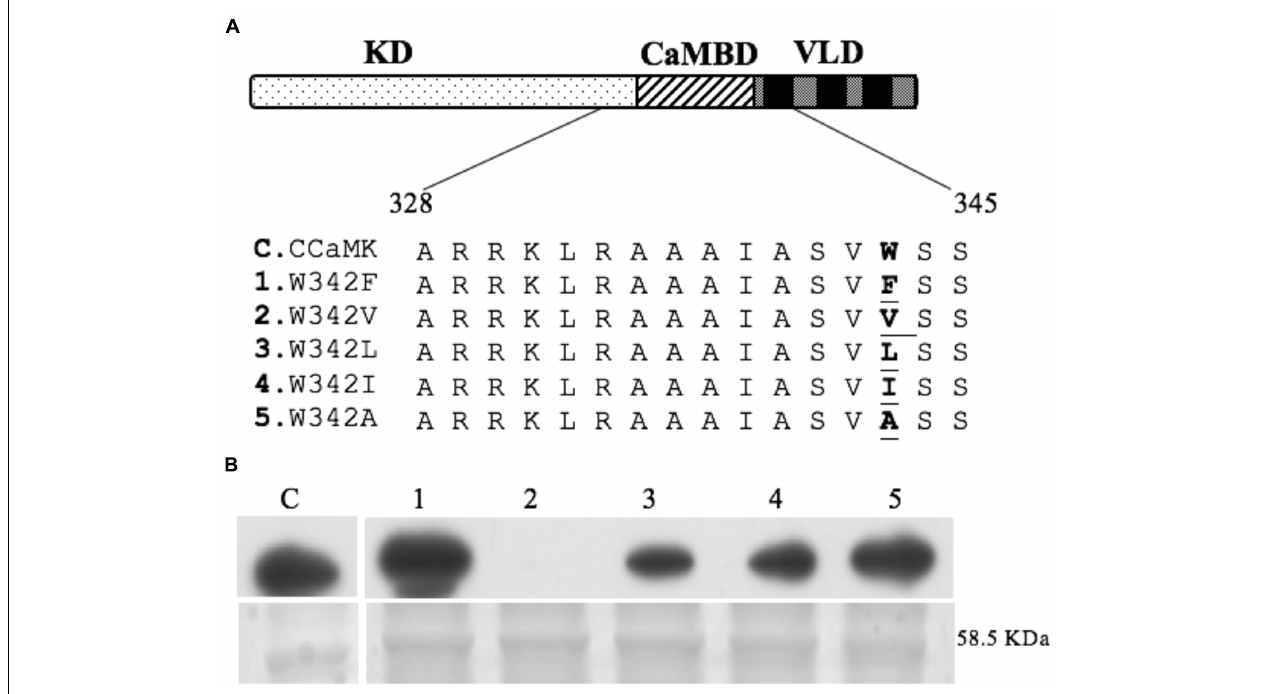
FIGURE 1 | Site-directed mutants and calmodulin-binding assay. Protein structure of CCaMK contains three domains: kinase domain (KD), calmodulin-binding/autoinhibitory domain (CAMBD) and visinin-like domains (VLD). Five mutants were generated by substituting the residue Trp-432 in the calmodulin-binding/autoinhibitory domain of CCaMK (A) . For calmodulin-binding assay (B) , total proteins from Escherichia coli (BL21) expressing the pET28-CCaMK or its mutated versions were separated on SDS–PAGE, transferred to PVDF membrane and incubated with horseradish peroxide (HRP)-conjugated CaM in the presence of Ca 2 + (1 mM). Upper: Calmodulin binding overlay assay of wild-type and all 5 of the mutants of CCaMK as showed in “ A ”; Lower: Coomassie staining of proteins from E. coli (BL21) expressing the pET28-CCaMK or its mutated versions (protein size: 58.5 kDa). The CaM-binding assay was repeated at least 4 times to corroborate the